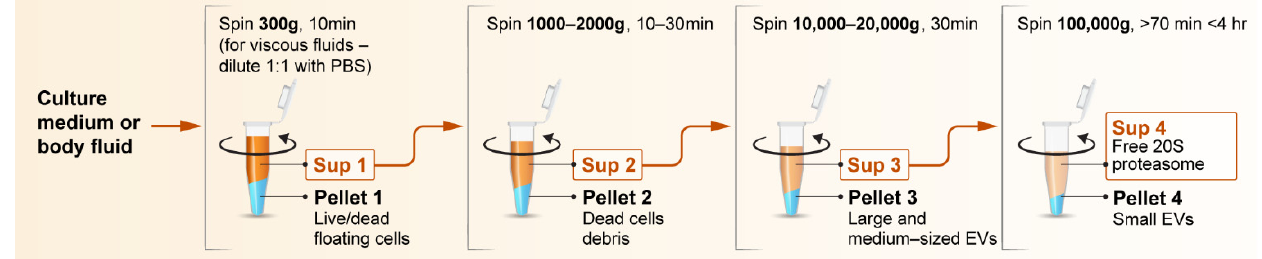
Figure 4. Recommendation of distinct centrifugation steps for handling body fluids and cell culture media directed towards proteasome investigation. Initially, the liquid should be centrifuged at 300– 500 g to remove live and dead floating cells without rupturing them, to minimize spillage of their contents into the extracellular fluid. The supernatant (Sup) should then be centrifuged at 1000–2000 g, to pellet insoluble dead cell debris. At this stage, the cleared fluid will contain a variety of different extracellular vesicles, as well as freely floating proteasomes. Centrifugation at 10,000–20,000 g will pellet large- and medium-sized EVs, and another round of ultracentrifugation at 100,000 g will pellet small EVs. The final supernatant will contain free proteasome particles.